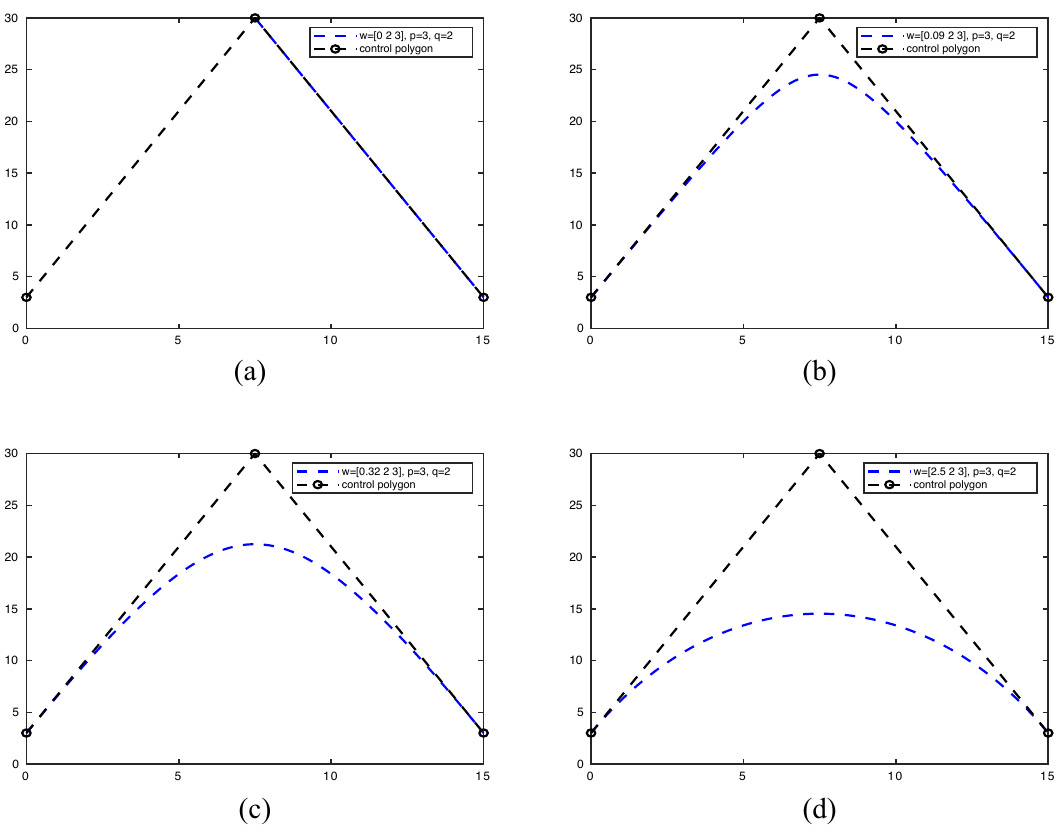
Figure 3: Conic sections produced by di ff erent w 1 . ( a ) Line, ( b ) ellipse, ( c ) parabola, ( d )